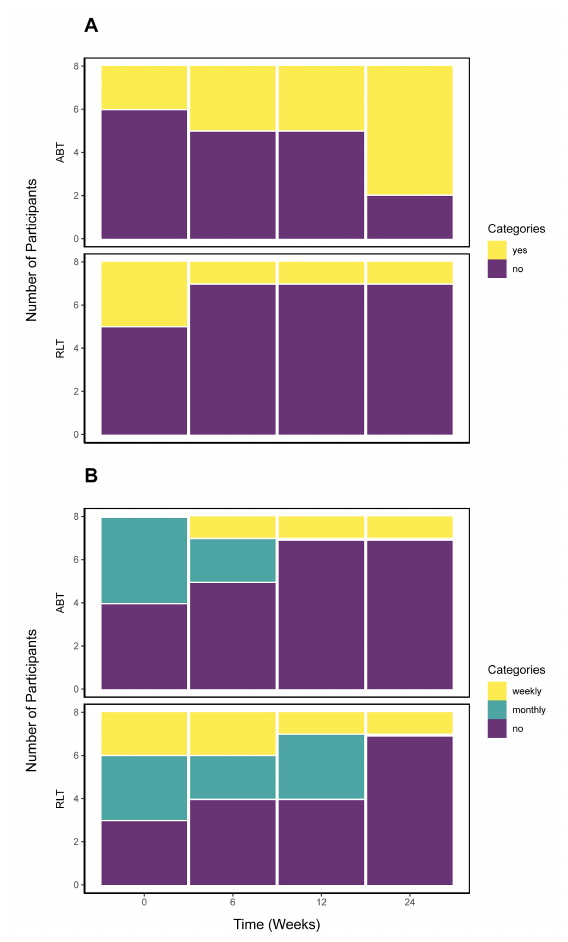
Fig. 1. Results of the International Lower Urinary Tract Func- tion Basic Data Set for the Robotic Locomotor Training and Activity-based Training groups over time. (A) Improvement in urinary function, (B) Frequency of urinary incontinence. RLT, Robotic Locomotor Training (n = 8); ABT, Activity-based Train- ing (n = 8). Improvements in bladder function were taken for the previous year, hence why change can be seen at week